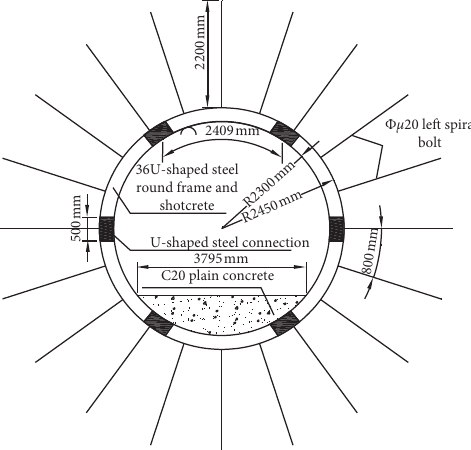
Figure 6: The floor bolt-mesh-shotcrete and 36U-shaped steel round frame combined support